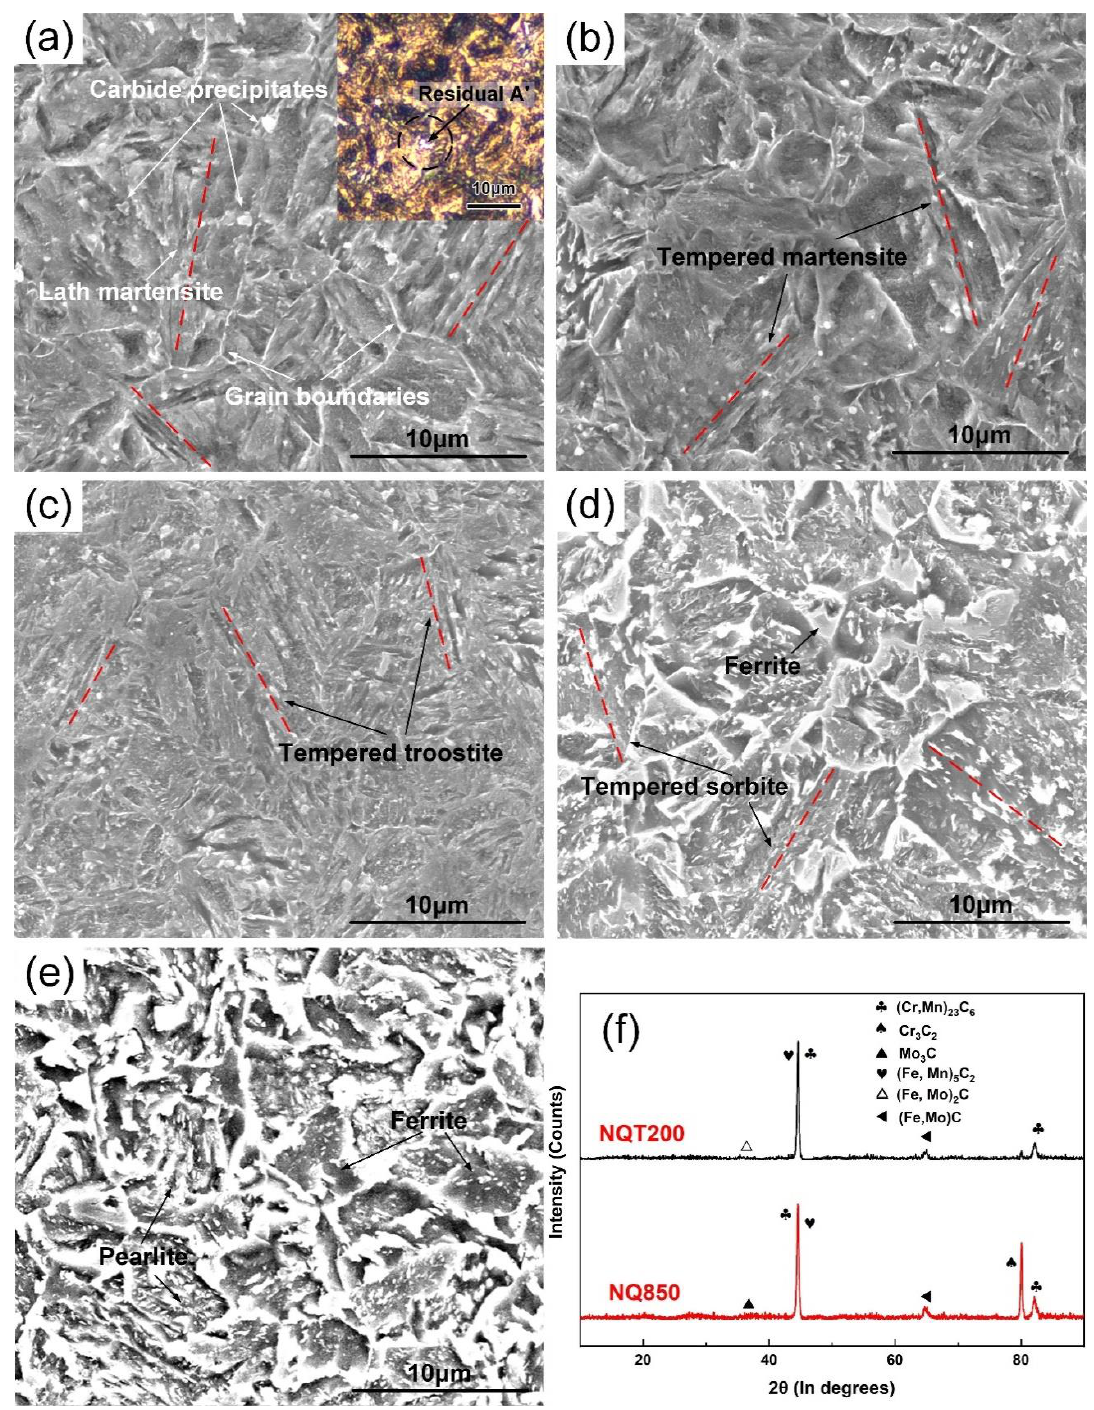
Figure 12. Microstructure of quenched steel after tempering at different temperatures: ( a ) no tempering (NQ850), ( b ) at 200 °C (NQT200), ( c ) at 350 °C (NQT350), ( d ) at 550 °C (NQT550), ( e ) at 850 °C (NQT850); (f) X-ray diffraction (XRD) patterns under NQ850 and NQT200 states.